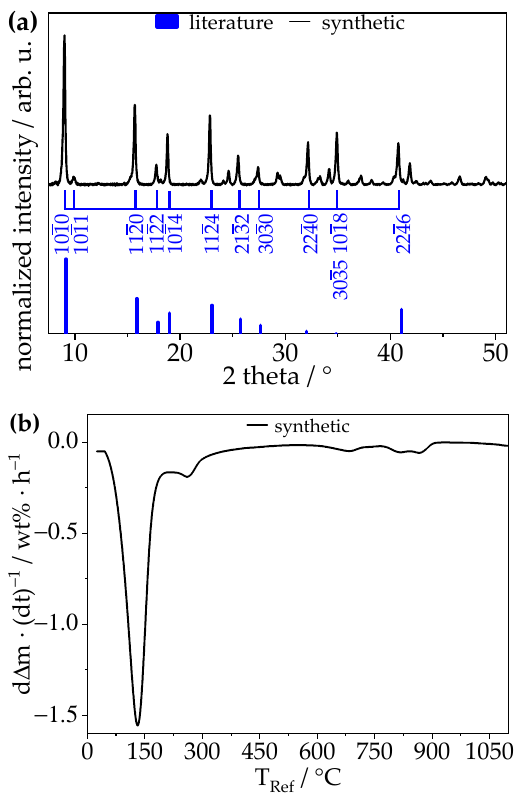
Figure 1. ( a ) Powder X-ray diffraction pattern of synthetic ettringite (black) and its literature data reflections (blue) [9,23] indexed using Bravais–Miller indices according to a trigonal symmetry in a hexagonal cell and ( b ) TGA data plotted as mass normalized time derived weight loss (d Δ m ∙ (dt) − 1 ) per hour against the reference temperature of synthetic ettringite with a heating rate of 5 °C/min.